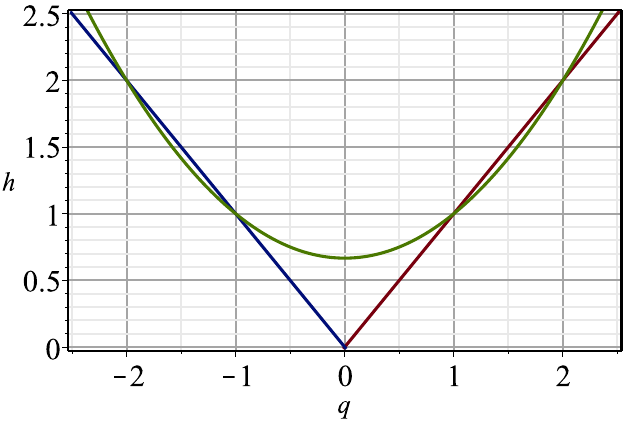
Figure 1 . The parabola of conformal weights ( h ) of operators related to the bare twist as a function of charge ( q ) for the case n = 3. One can see the bare twist at q = 0, as well as the chiral primaries at q = 1 ; 2 which intersect the line h = q . The anti chiral primaries are likewise given by the intersection of the parabola with h = (cid:0) q at q = (cid:0) 1 ; (cid:0) 2. Note that in the windows q 2 (1 ; 2) and q = ( (cid:0) 2 ; (cid:0) 1) these operators violate the h (cid:21) j q j bound necessary to have unitary representations of superconformal theories. This window is excluded if one allows spectral (cid:13)ow only in steps (cid:24) = 1 = 3, i.e., (cid:24) = 1 =n , from the bare twist. These are exactly the step sizes needed to ensure that the ( J i ) (cid:20)=n (cid:12)elds are single